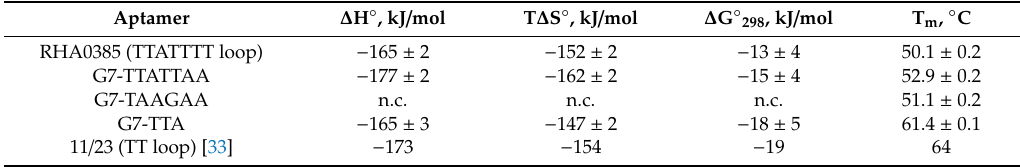
Figure 2. The circular dichroism (CD) spectra of melting of G-quadruplex aptamers from 30 to 70 °C: ( A ) RHA0385, ( B ) G7-TTATTAA, ( C ) G7-TAAGAA; and from 30 to 80 °C: ( D ) G7-TTA. The difference of temperatures between two adjacent spectra was 2.5 °C, the rate of heating was 0.5 °C/min. Table 1. Thermodynamic parameters and T m of G-quadruplex aptamers folding. Comparison with parameters of parallel G-quadruplex 11 / 23 (TGAGGGTTGGGAGGGTGGGTAA) [33] is